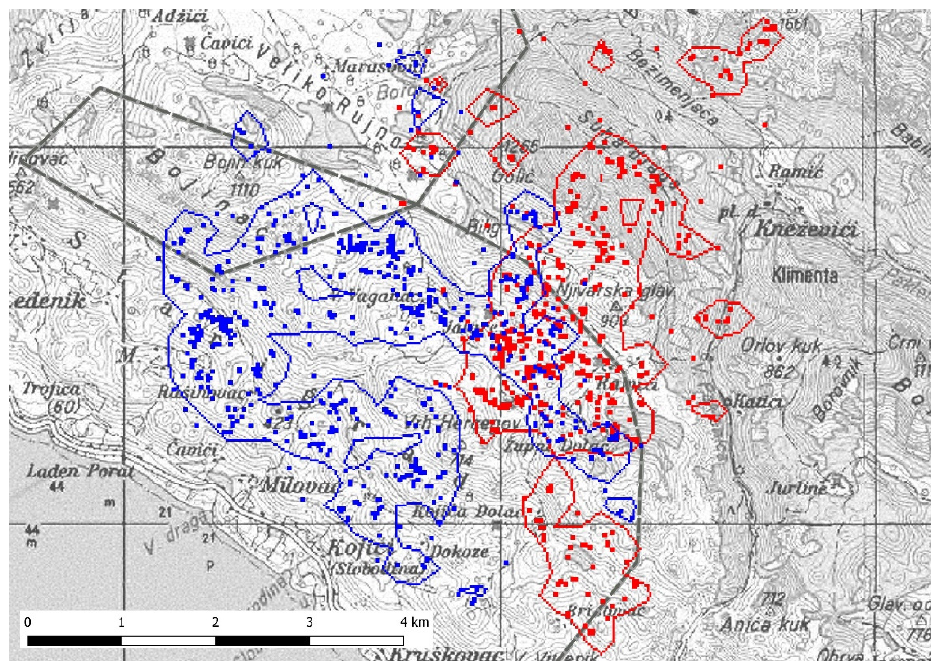
Figure 2. Seasonal home ranges (BBMM 95%) of bear B95 (blue) and bear B97 (red) for September until November 2019. Dark grey dashed line shows National Park border. Scale: 1:33,000.